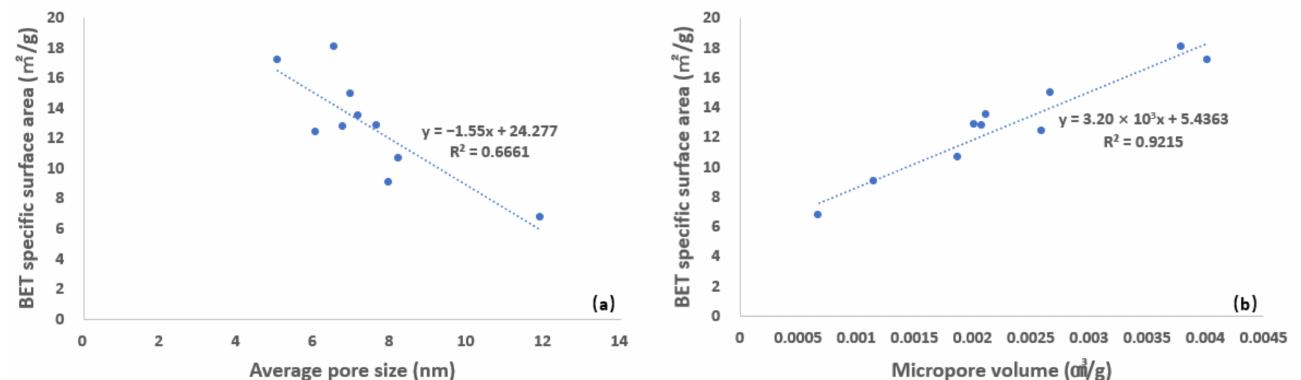
Figure 6. Relationship between BET-specific surface area and pores; ( a ) the cross plot of BET-specific surface area and the average pore size; ( b ) the cross plot of BET-specific surface area and the micropore